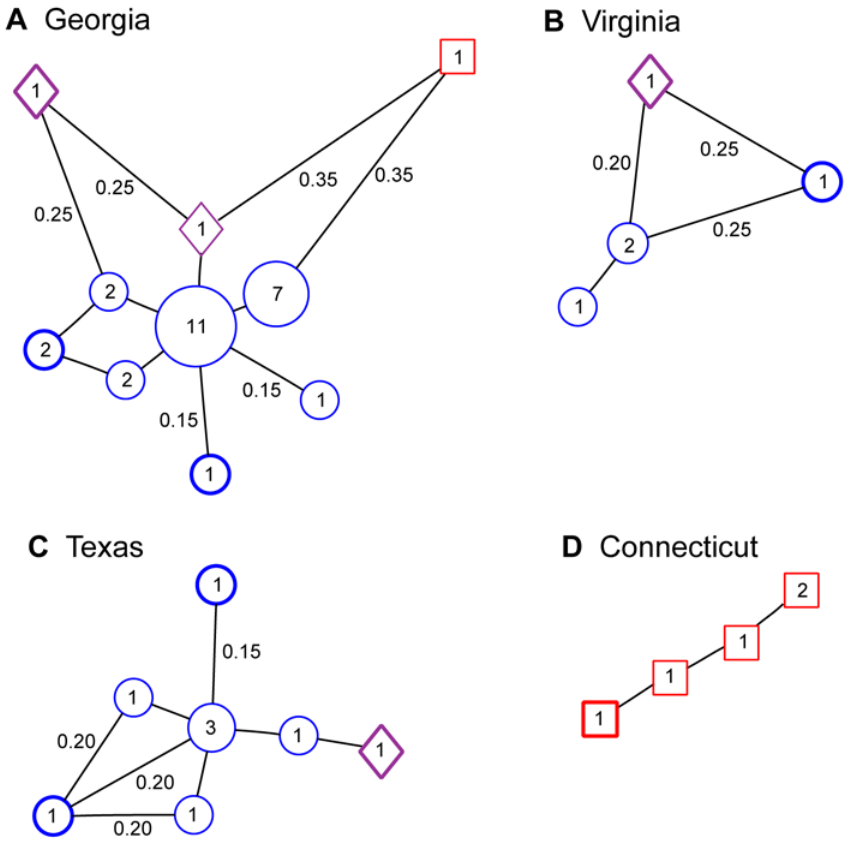
Figure 3. Minimum spanning networks for four 2004 NA1 populations. A. Georgia, B. Virginia, C. Texas, and D. Connecticut. Multilocus genotypes were collapsed to multilocus haplotypes, which are represented by circles, squares, or diamonds containing the number of associated isolates and sized in proportion to haplotype frequency. Blue circles and red squares represent the two different groups identified by Structure. Purple diamonds are haplotypes that could not be assigned to one group or the other with high confidence ( . 75% probability). Bolded haplotypes are those that were found in only that state. Branches are proportional to Bruvo et al. ’s [56] genetic distance and are labeled with distance if different than 0.10. Loops in the networks indicate multiple tied minimum spanning trees. For GA, TX, and VA the most common haplotype corresponds to MG 1 in Table S2. The most common haplotype for CT is MG 2.